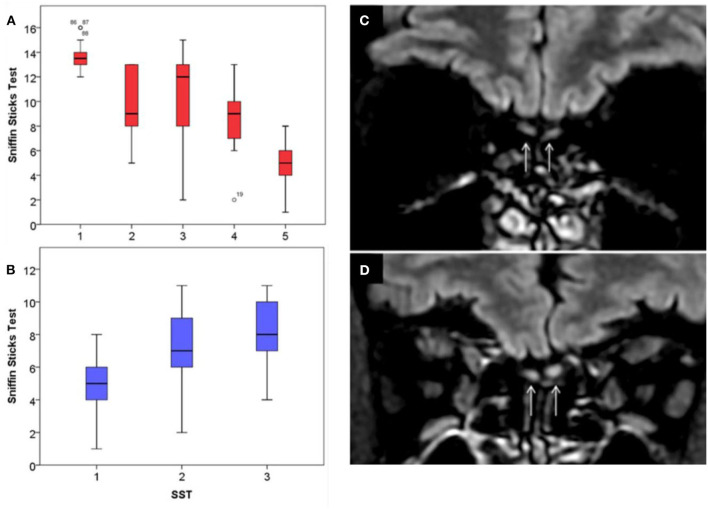
Sniffin-Sticks-test features and imaging of olfactory bulb. The first Sniffin-Sticks-tests (SST) of COVID-19 patients are represented in (A). The median value of SST was presented regarding the following patient recovery subgroups: 1 (recovery: 1–14 days), 2 (15–30 days), 3 (31–45 days), 4 (45–60 days), and 5 (no recovery). Patients of group 5 had a lower baseline SST compared with other groups (p < 0.001). The mean value of SST of patients of group 5 significantly improved throughout the first 2 months following the onset of anosmia, represented in (B). Comparison of T2/FLAIR coronal views centered on the olfactory bulbs showed normal signal in a normosmic (C) and T2/FLAIR hyperintensity of the olfactory bulbs in a patient with anosmia (D).